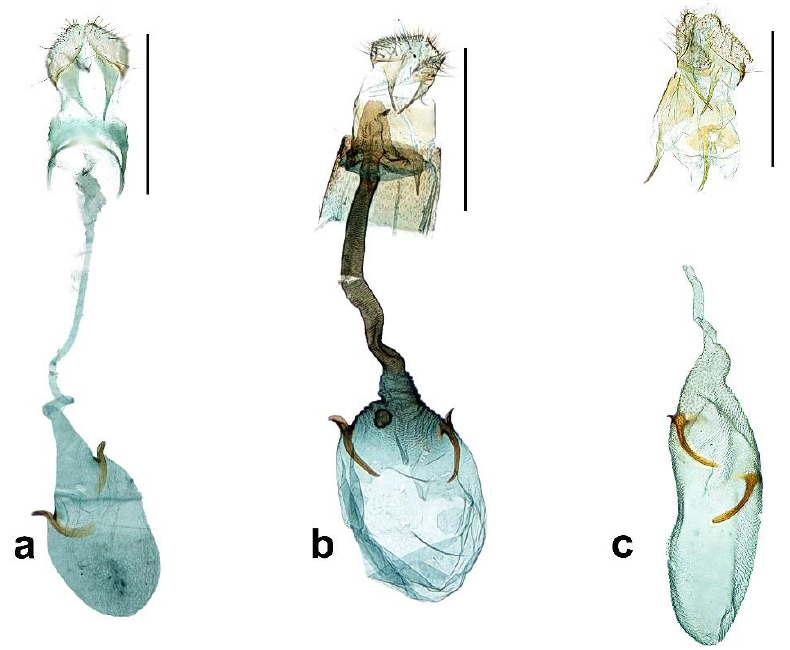
Figure 3. Female genitalia of Caloptilia . ( a ). C. purpureus (gen. slide no. HNUSEL-5591); ( b ). C.